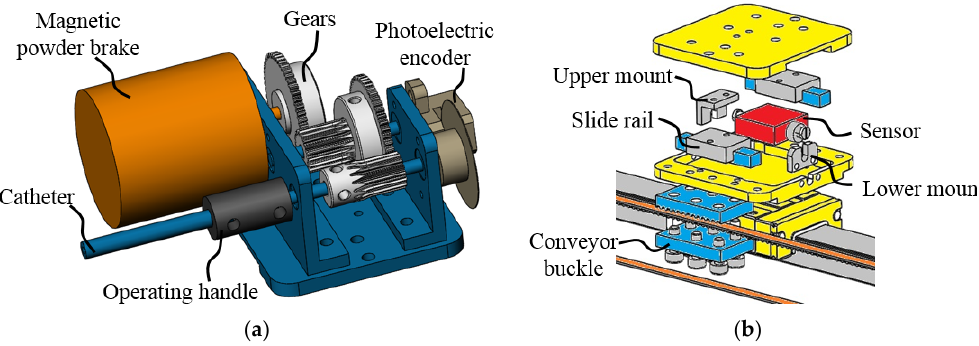
Figure 4. Detailed structure of the controller platform. ( a ) Schematic of the upper controller platform. ( b ) Structure diagram of linear force feedback evaluation mechanism.